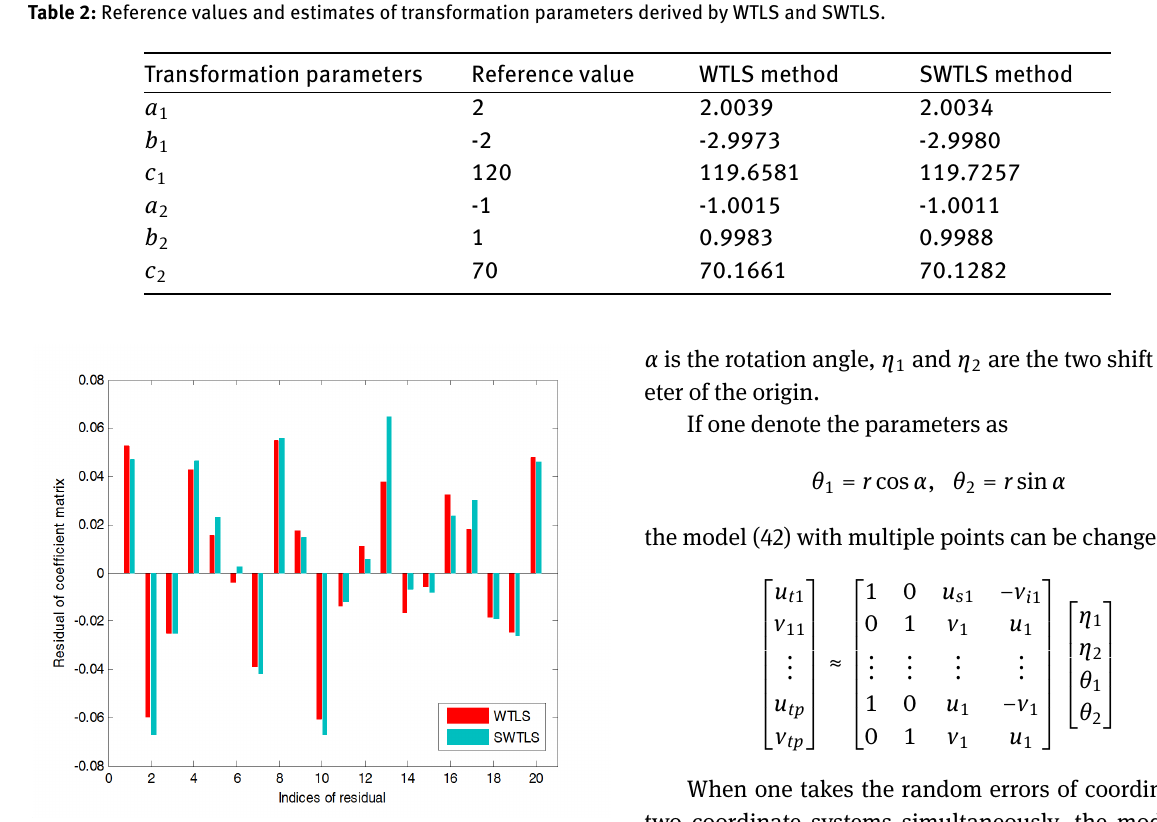
Figure 2: Residuals of coeflcient matrix.